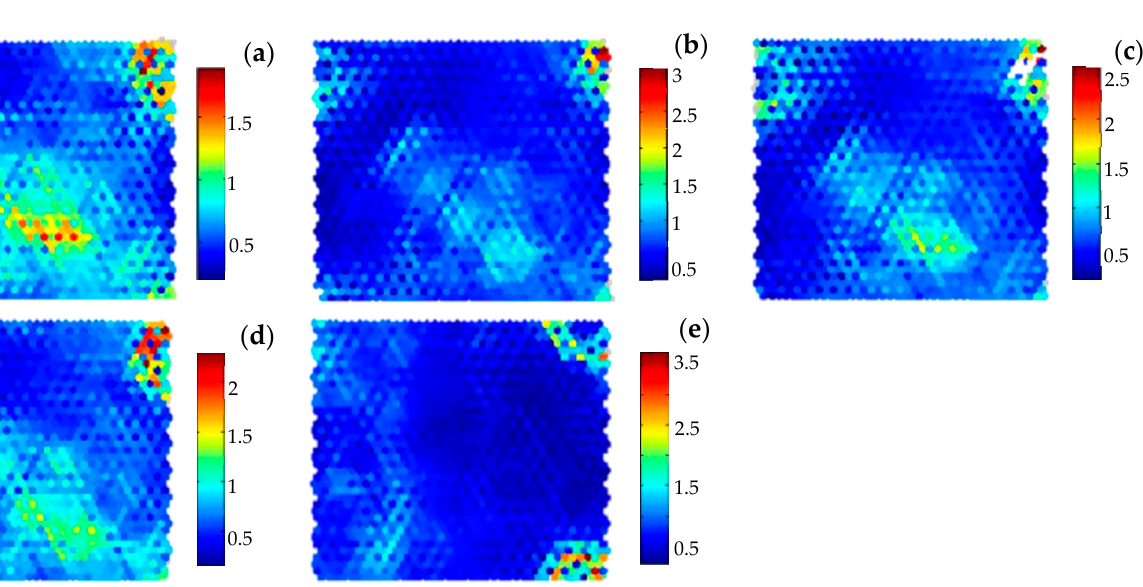
Figure 11. Representation of the U-matrix, with the exclusion of ( a ) 10%, ( b ) 20%, ( c ) 30%, ( d ) 40%, and ( e ) 50%.